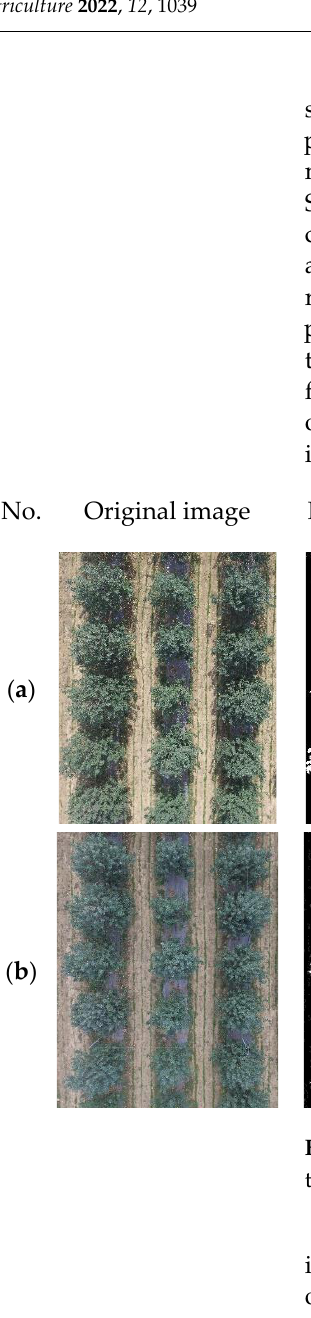
Table 2. Comparison of the evaluation indicators (P, R, F1) of different segmentation algorithms.